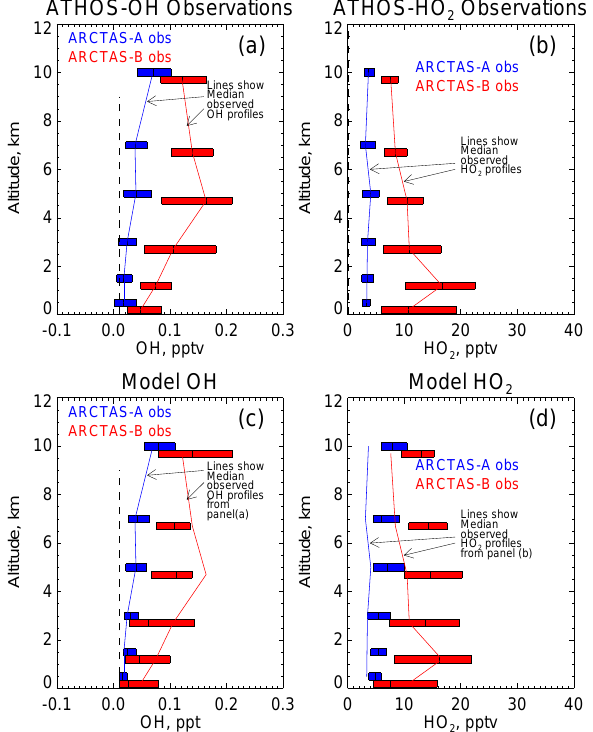
Fig. 8. Profiles of observed (a) OH and (b) HO 2 and of model- predicted (c) OH and (d) HO 2 during ARCTAS. Bar plots are as described in Fig. 2. The lines indicate the median observed profiles of OH and HO 2 .